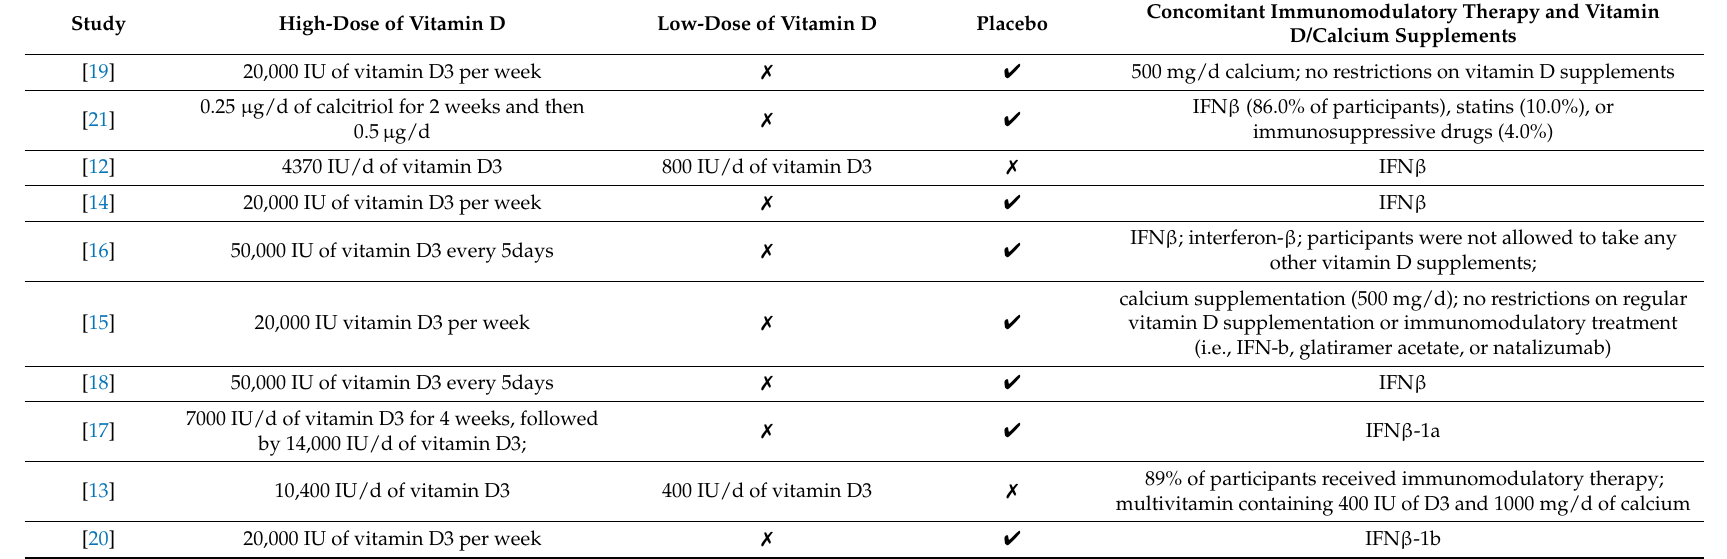
Table 6. Dose of vitamin D and concomitant immunomodulatory therapy used in selected studies. Study High-Dose of Vitamin D Low-Dose of Vitamin